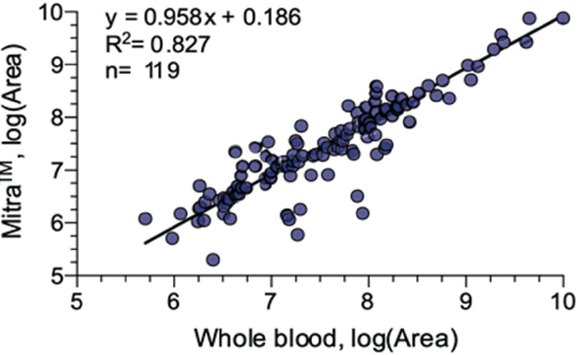
Figure 6. Correlation between the chromatographic peak areas of 119 molecules identified in whole blood and Mitra TM devices.